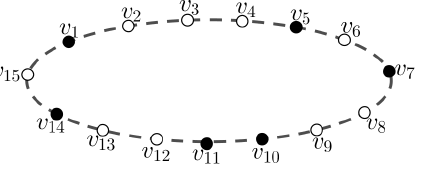
Figure 2. B 10 = K 10 − E ( C 10 ) with its Q = { v 1 , v 5 , v 7 , v 10 , v 11 , v 14 }